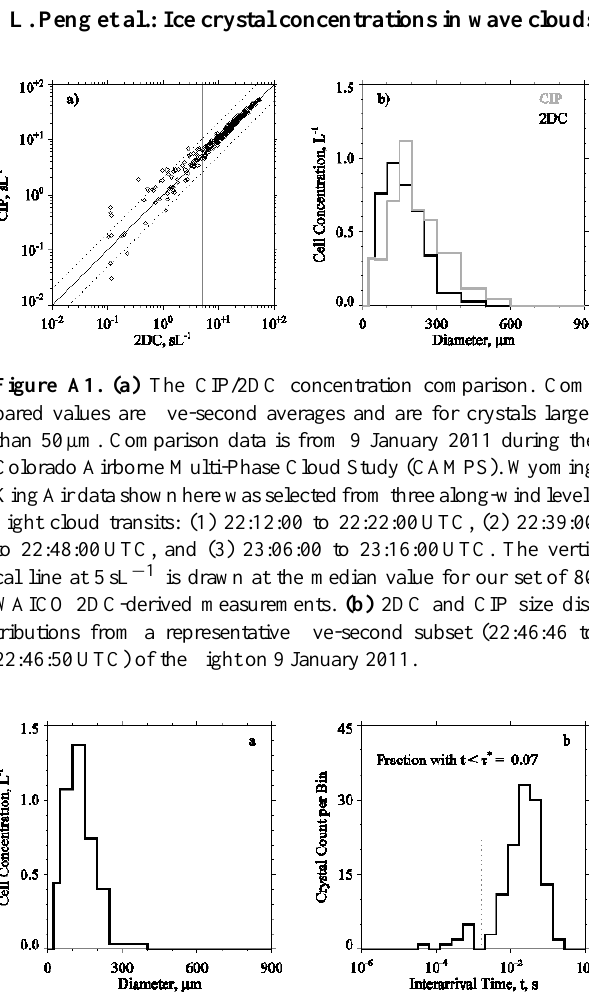
Figure A2. (a) The 2DC size distribution derived for the WAICO 18:19:33 to 18:19:37UTC interval on 27 February 2008. This in- terval corresponds to the downwind track–streamline intersection at x = 15km in Fig. 1c. (b) The interarrival time histogram for the 18:19:33 to 18:19:37UTC interval on 27 February 2008. The vertical dashed line marks a minimum between a fragment mode ( t < τ ∗ ) and a mode corresponding to intact crystals ( t > τ ∗ )